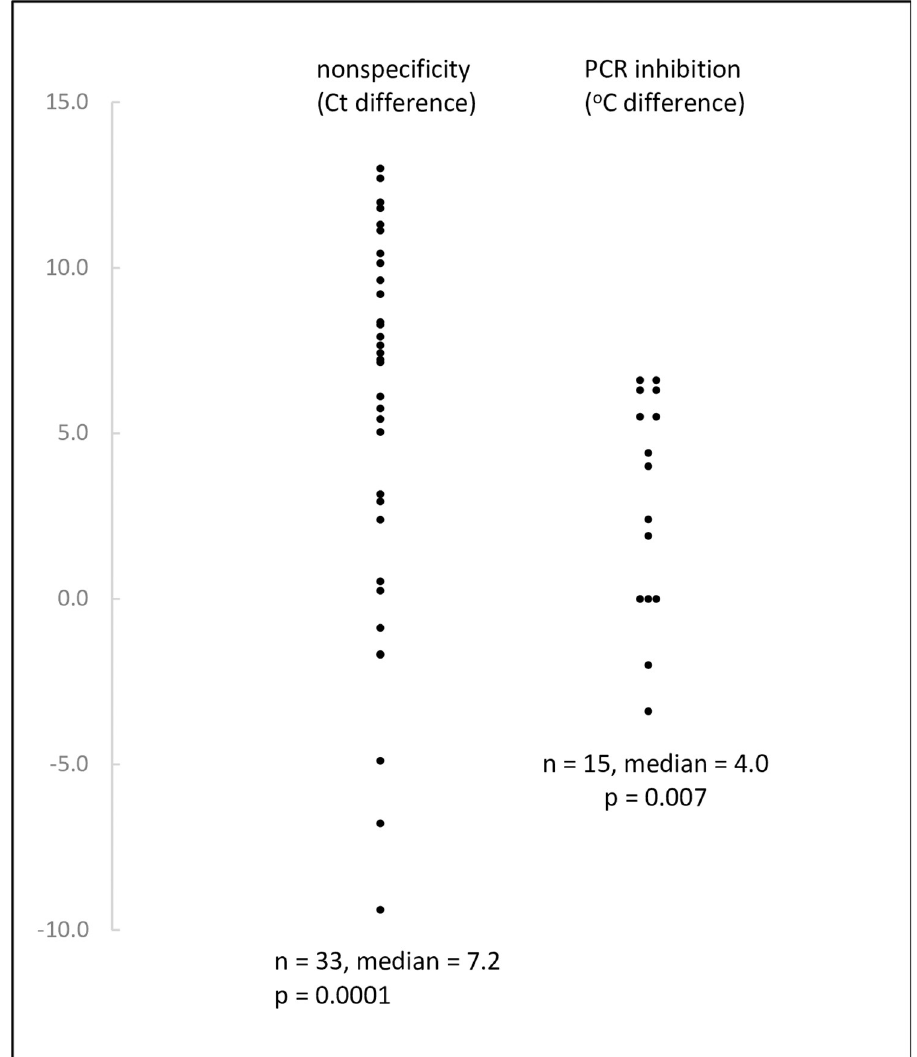
Fig 4. Effect of the 3’ end of the primer on production of nonspecificity and PCR inhibition. Experiments were performed with a gradient of annealing temperature. The Ct difference is the Ct for an A/T primer minus the Ct for a G/C primer and the positive value of the median indicated that, at the same annealing temperature, G/C primers evidenced a lower Ct and therefore more nonspecificity. The ˚C difference is the temperature difference between G/C and A/T primers in the minimum annealing temperature required to prevent inhibition. The positive value of the median indicated that G/C primers required a higher annealing temperature to prevent inhibition. The statistical test was the Wilcoxon matched-pairs signed-rank